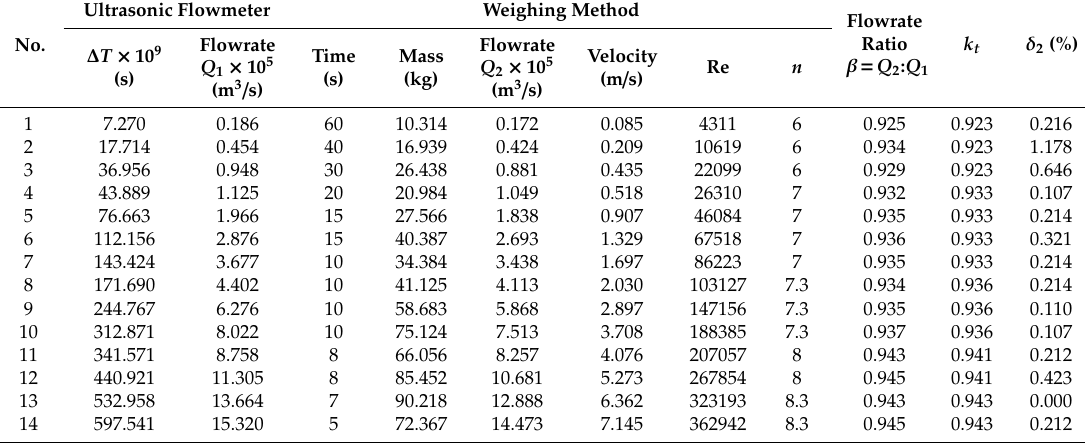
Table 3. Results of flowrate measurement at the performance testing system for centrifugal